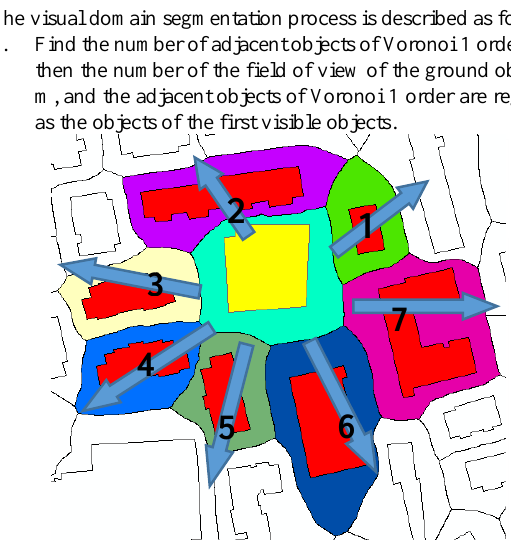
Figure .1 The first order adjacent ground objects of the ground object